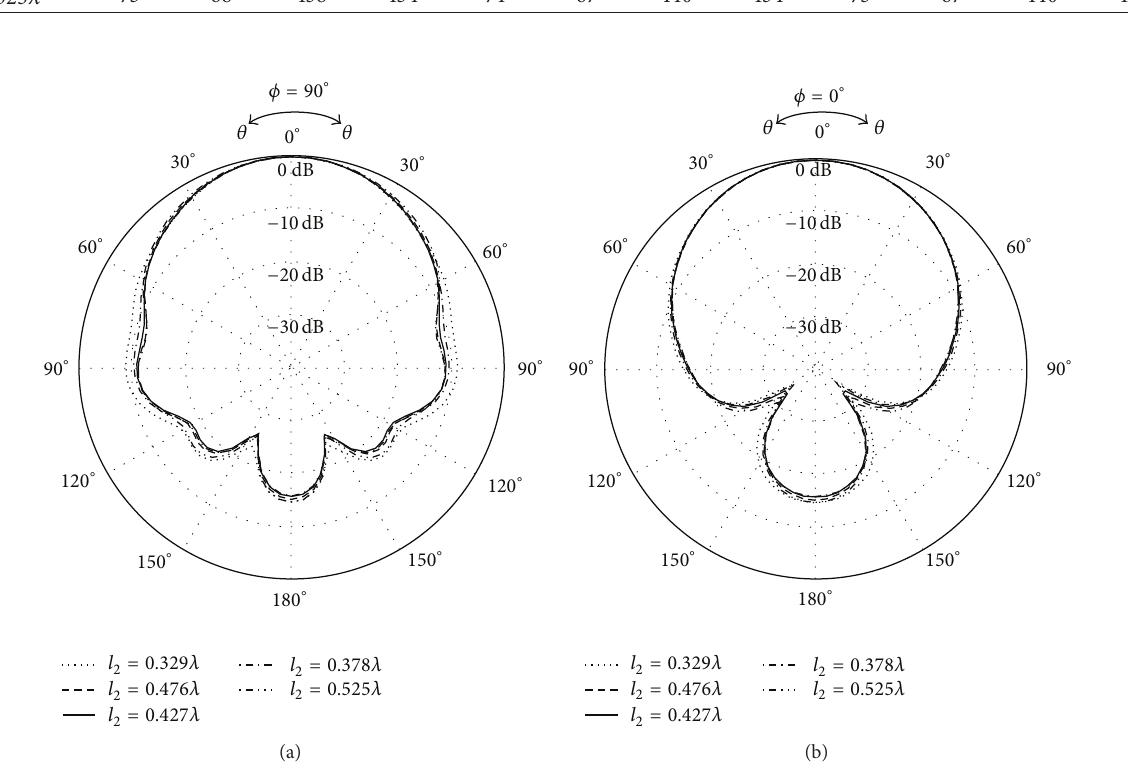
Figure 16: Simulated radiation patterns for various parasitic coupling aperture lengths ( 𝑙 2 ) at the lower frequency of 2.412 GHz in (a) the 𝐸 -plane and (b) the 𝐻